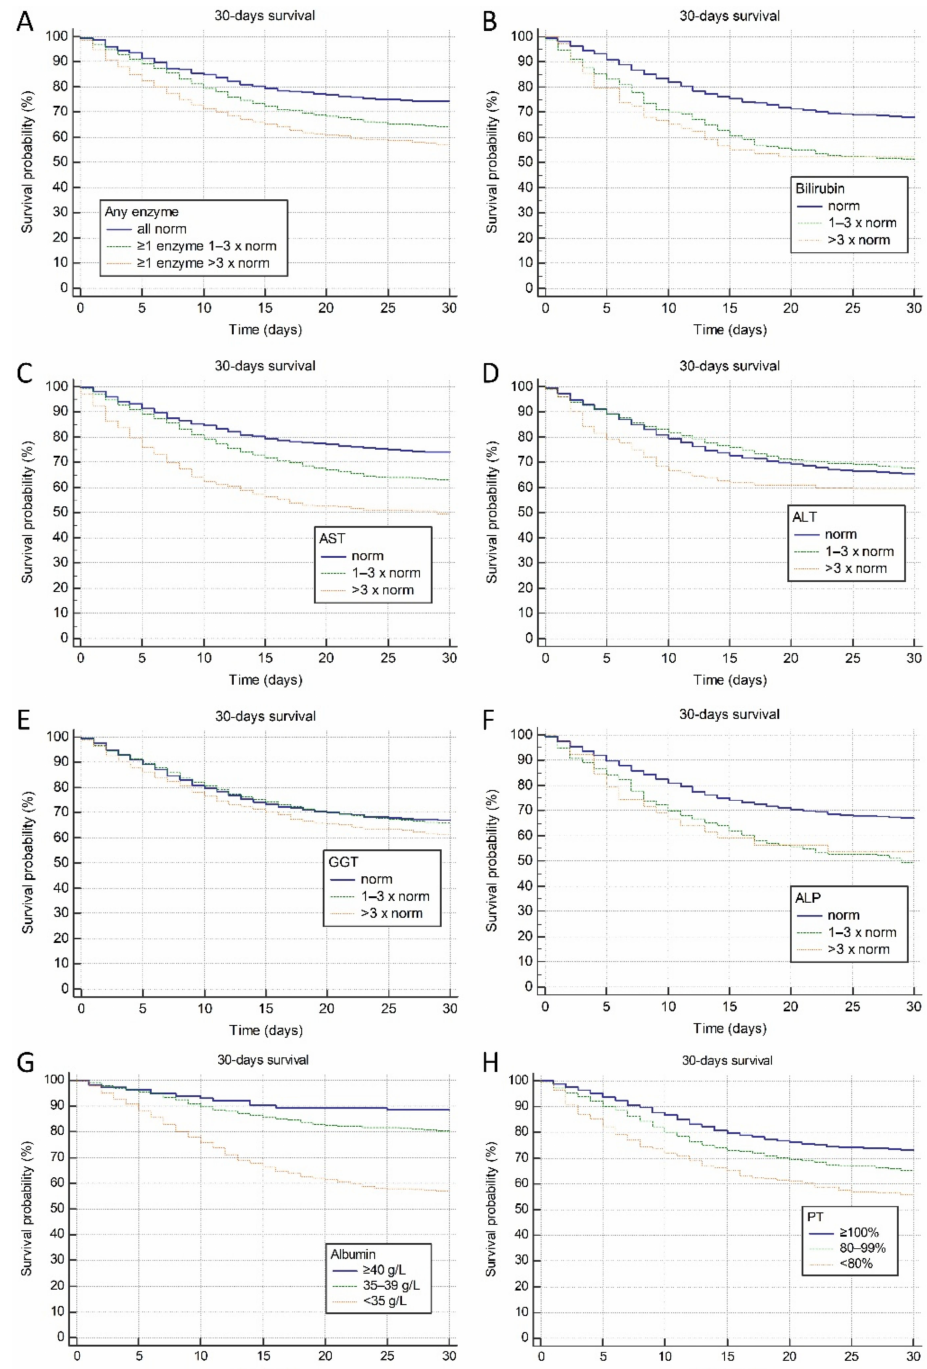
Figure 1. Association of the degree of liver blood tests derangement and 30-day mortality. ( A ) eleva- tion in any of AST, ALT, GGT, ALP, total bilirubin. Elevation in ( B ) total bilirubin, ( C ) AST, ( D ) ALT, ( E ) GGT, ( F ) ALP, ( G ) reduction in albumin and ( H ) PT. Legend: AST—aspartate aminotransferase, ALT—alanine aminotransferase, GGT—gamma-glutamyl transferase, ALP—alkaline phosphatase, PT—prothrombin time (quick,